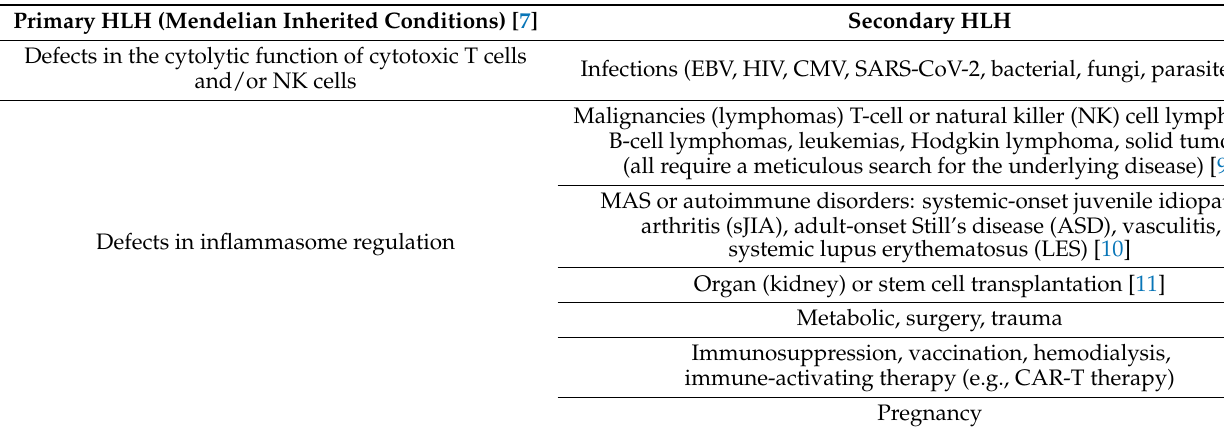
Table 1. Causes of primary and secondary HLH